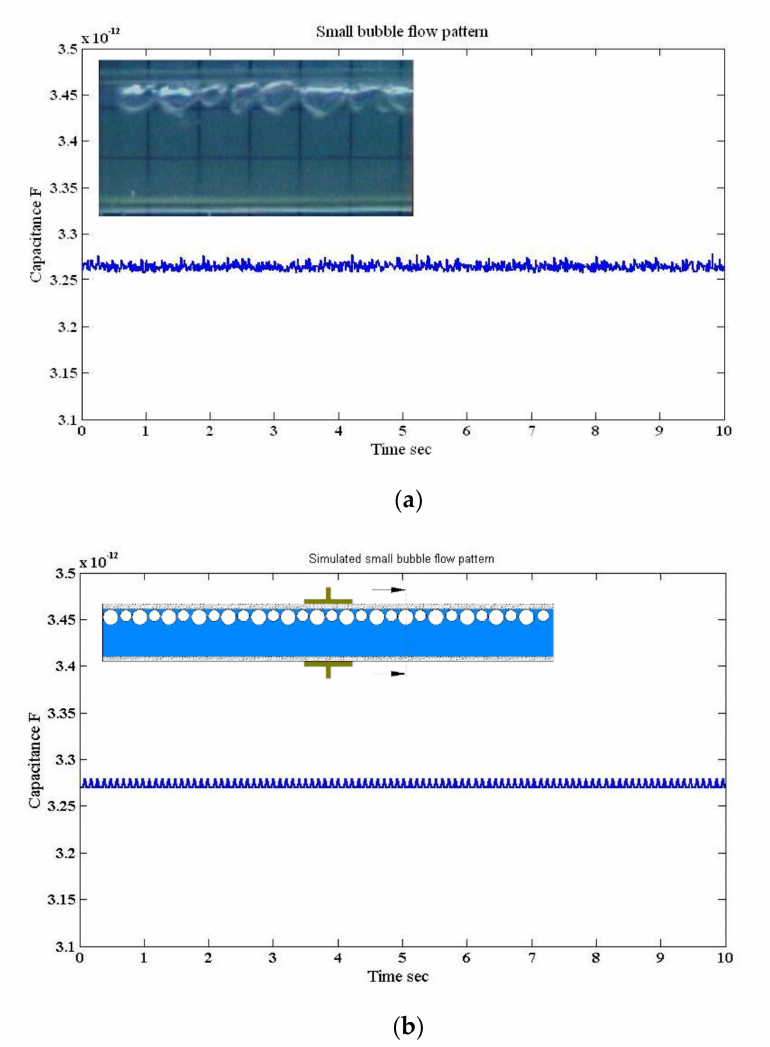
Figure 8. The time-dependent fluctuation of the capacitance value for a small bubble flow pattern: ( a ) experimental [32], and ( b ) simulation (for the superficial gas–liquid phase velocities 0.05 m / s and 0.94 m / s, respectively; inclination angle β = 0 ◦